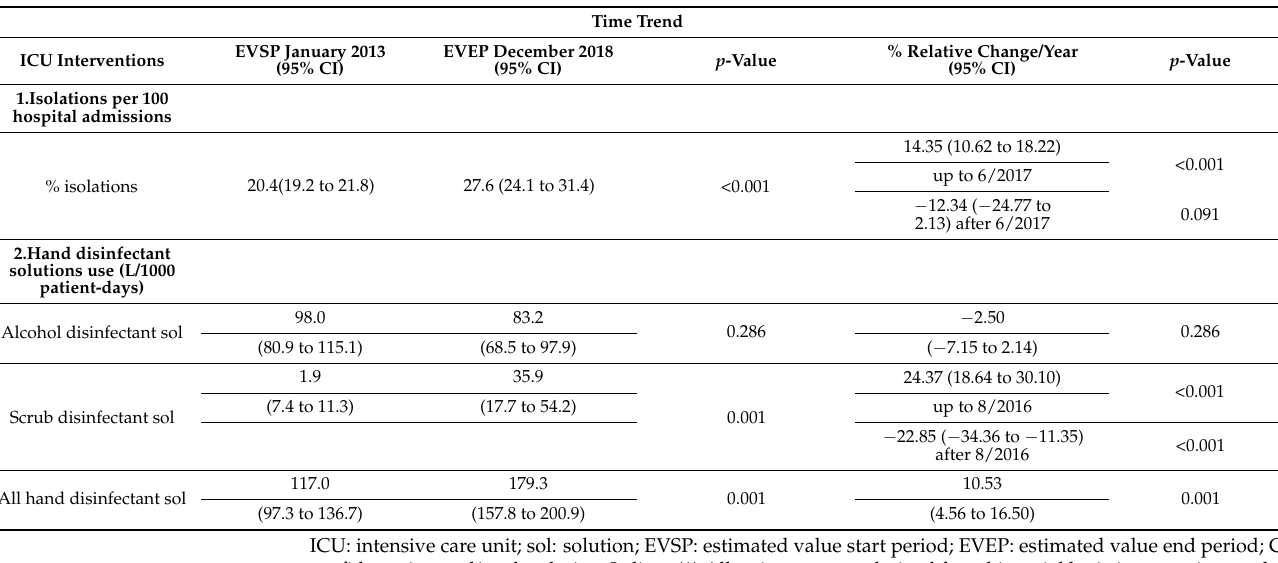
Table 3. Time trend of interventions over time in the ICU, January 2013 to December 2018. Time